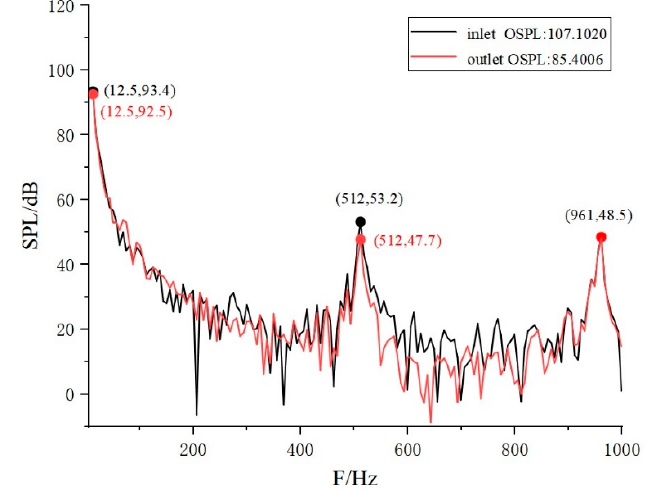
Figure 14. Sound pressure level curve at 120° angle.